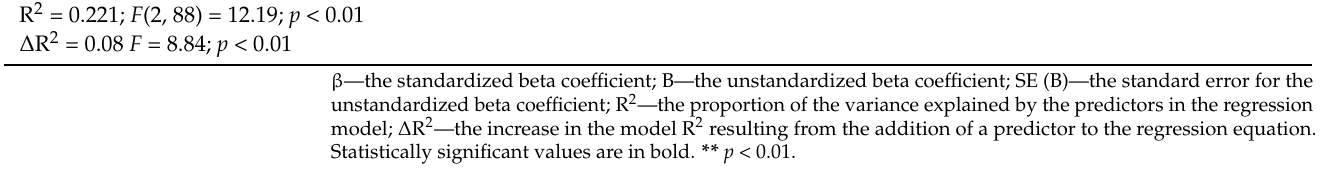
Table A3. Linear regression model of L2 methylation (%) predictors in carriers of rs6311 allele